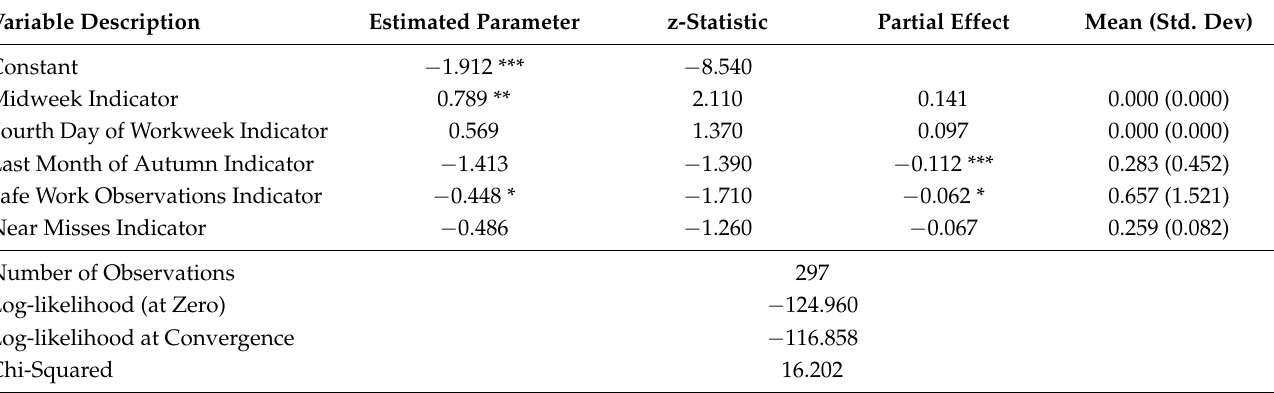
Table 4. Truncated Poisson model and average partial (marginal) effects of first aid